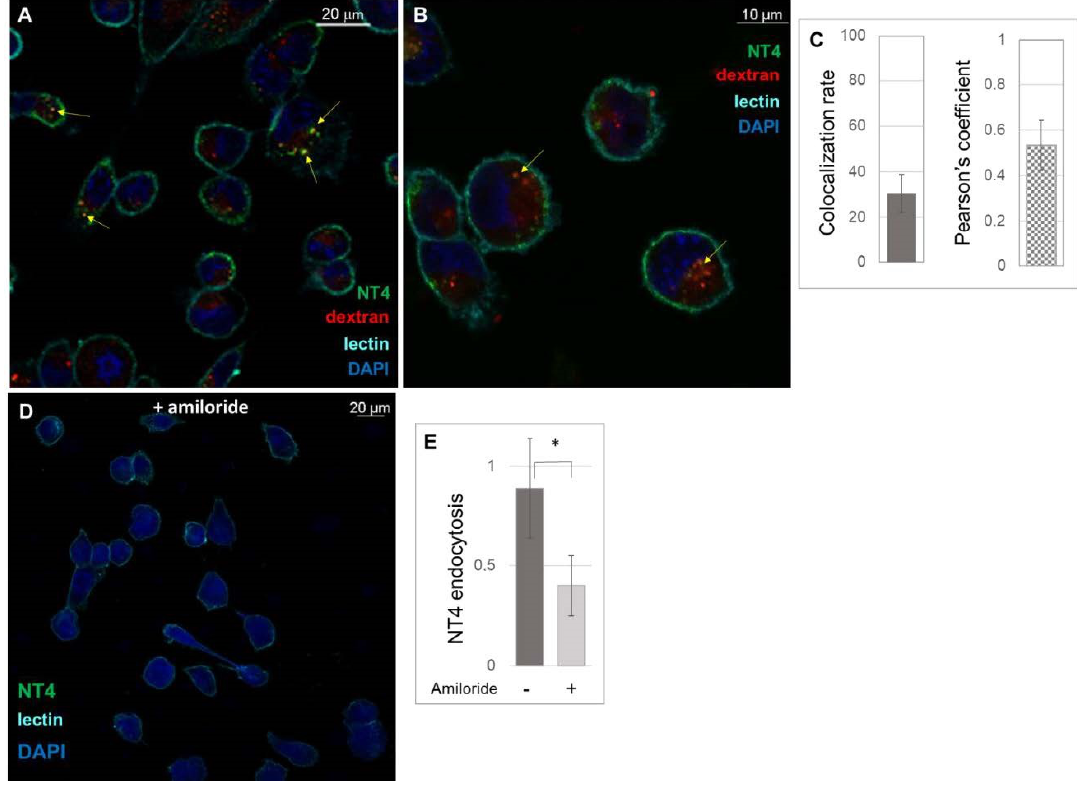
Figure 3. Macropinocytosis of NT4. ( A ) Confocal experiments of colocalization of NT4 (green) and dextran (red); ( B ) higher magnification of a confocal image of colocalization, yellow arrows indicate colocalization of NT4 and dextran; ( C ) measurement of colocalization of NT4 and dextran; ( D , E ) pre-treatment of MDA-MB-231 cells with amiloride impairs NT4 endocytosis (* p = 0.0461).